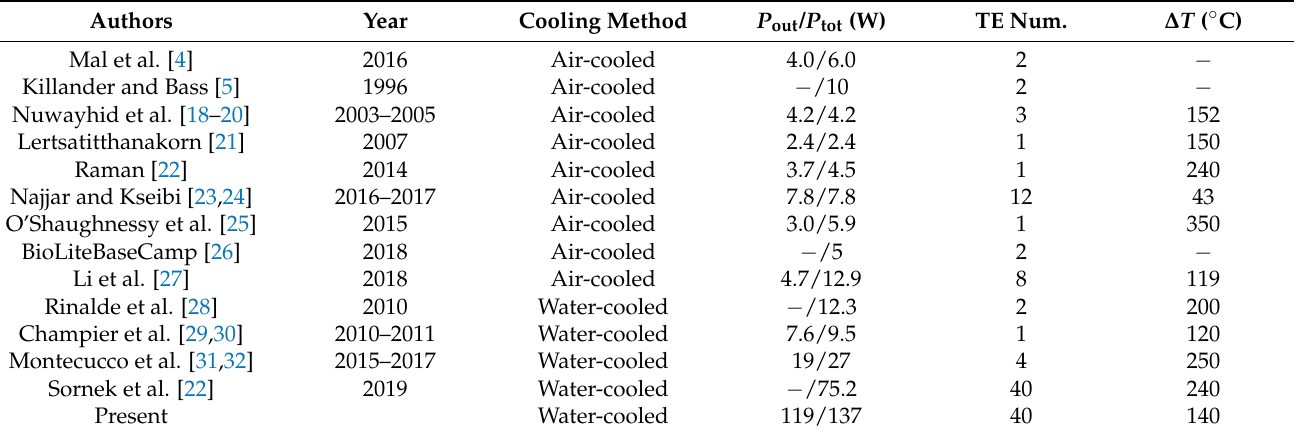
Table 1. Detailed comparisons of previous SPTEGs ( P out is the net power excluding the power consumption by water pumps and ∆ T is the temperature difference between the hot-end and the cold-end of the TE